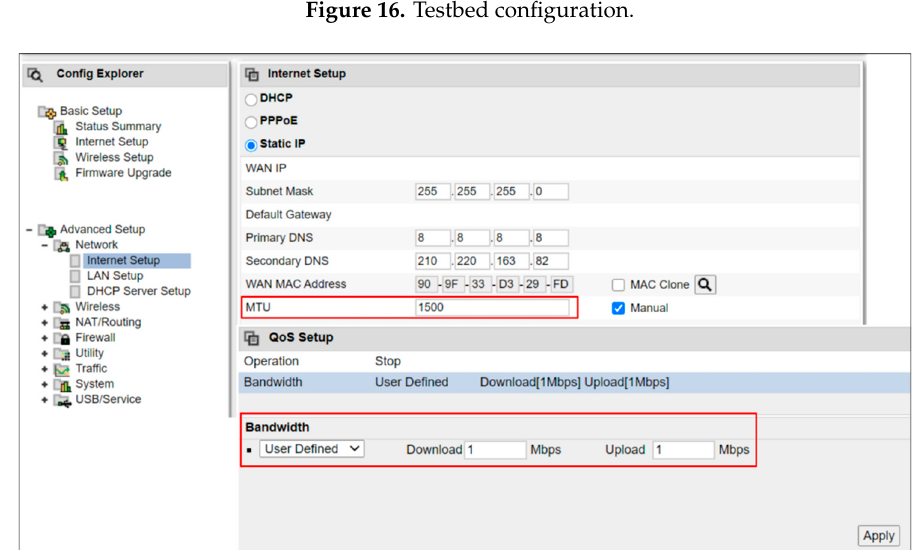
Figure 16. Testbed configuration.